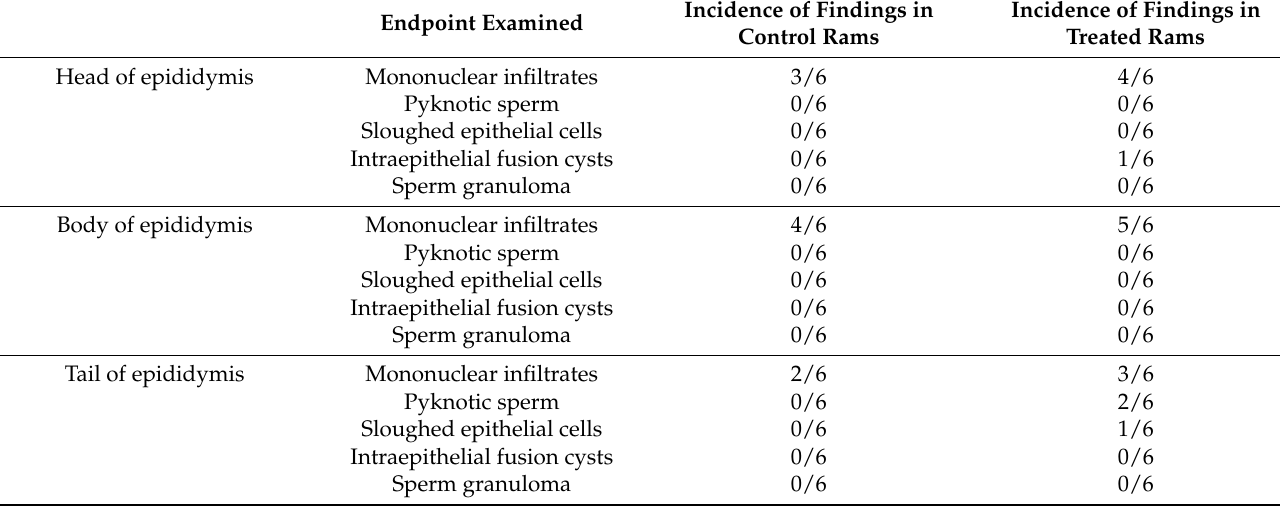
Table 3. Incidence of histopathological findings in epididymides of control and BPA-treated rams. Only mild lesions were detected in every endpoint examined.